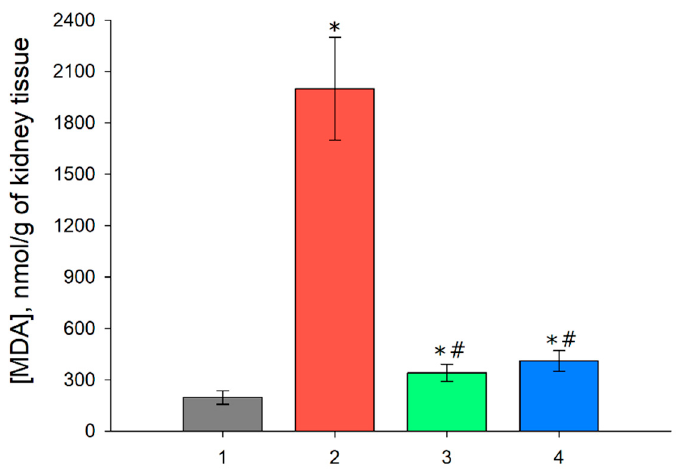
Figure 6. MDA level in kidney tissues ( n = 5 for each group). 1—Intact mice; 2—24 h after ischemia-reperfusion; 24 h after ischemia-reperfusion injury preceded by injection of Prx1 (3) and Prx2 (4). p < 0.05 relative to the * intact control and # I/R.